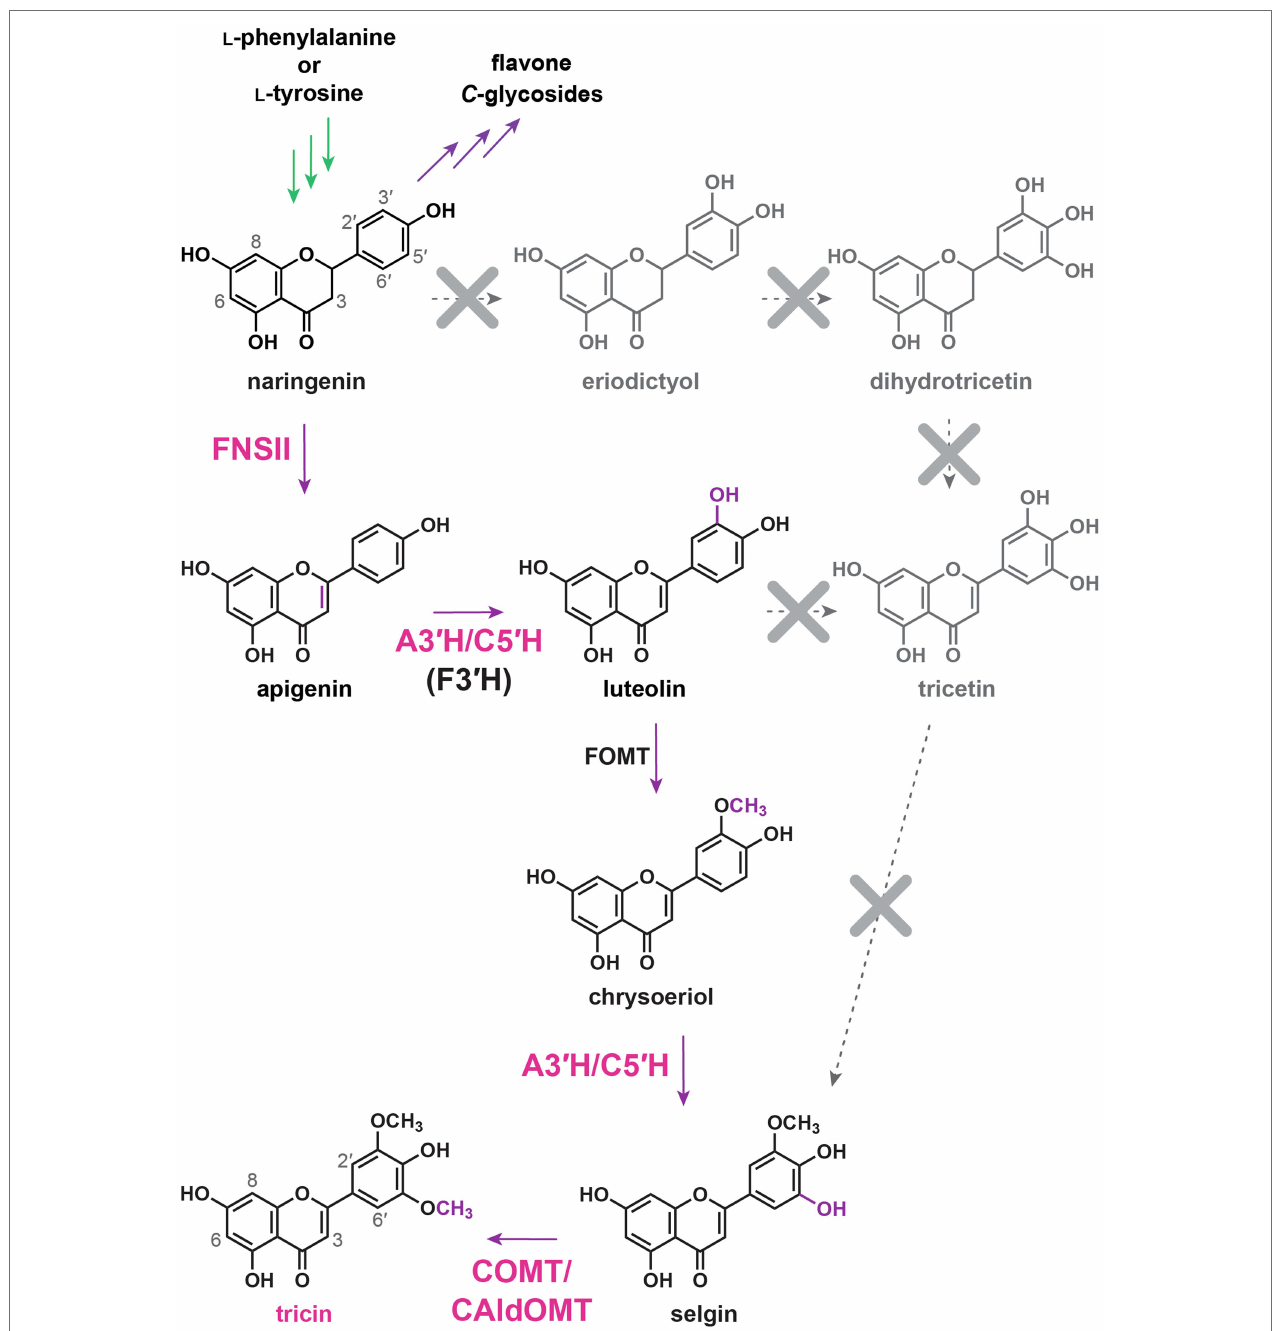
FIGURE 5 | Current understanding on tricin biosynthetic pathway in grasses. FNSII, flavone synthase II; A3 ' H/C5 ' H, apigenin 3 ' -hydroxylase/chrysoeriol 5 ' -hydroxylase; F3 ' H, flavonoid 3 ' -hydroxylase; FOMT, flavonoid O -methyltransferase; COMT, caffeic acid O -methyltransferases; and CAldOMT, 5-hydroxyconiferaldehyde O -methyltransferase. In green: general phenylpropanoid pathway. In purple: flavonoid biosynthetic pathways. Dotted arrows: originally proposed tricin biosynthetic